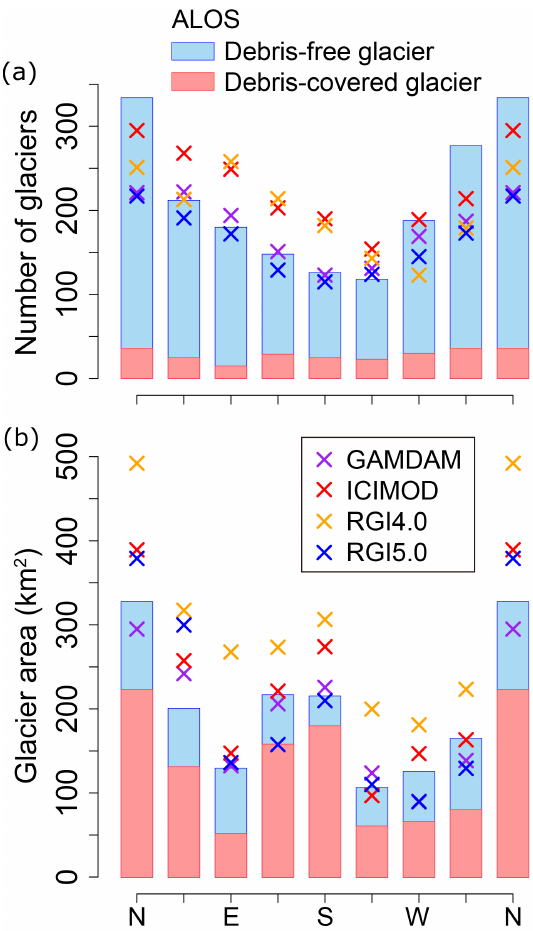
Figure 13. Cumulative glacier (a) number and (b) area of ALOS- derived glacier outlines, classified by aspect. Also plotted are total glacier number and area data from other